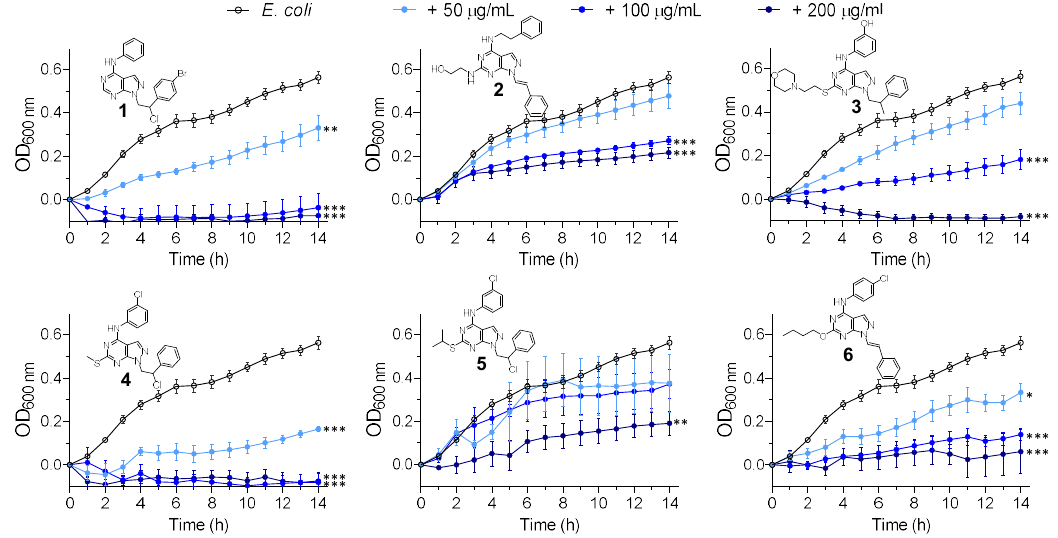
Figure 4. Growth curves of E. coli in the presence of increasing concentrations (50, 100 and 200 µg/mL) of pyrazolo[3,4- d ]pyrimidines (compounds 1 – 6 ). P -values of significance (* < 0.05, ** < 0.01 and *** < 0.001) were determined using one-way analysis of variance (ANOVA). Data are representative of at least 3 independent repeat experiments. Error bars indicate SEM. OD: optical density.